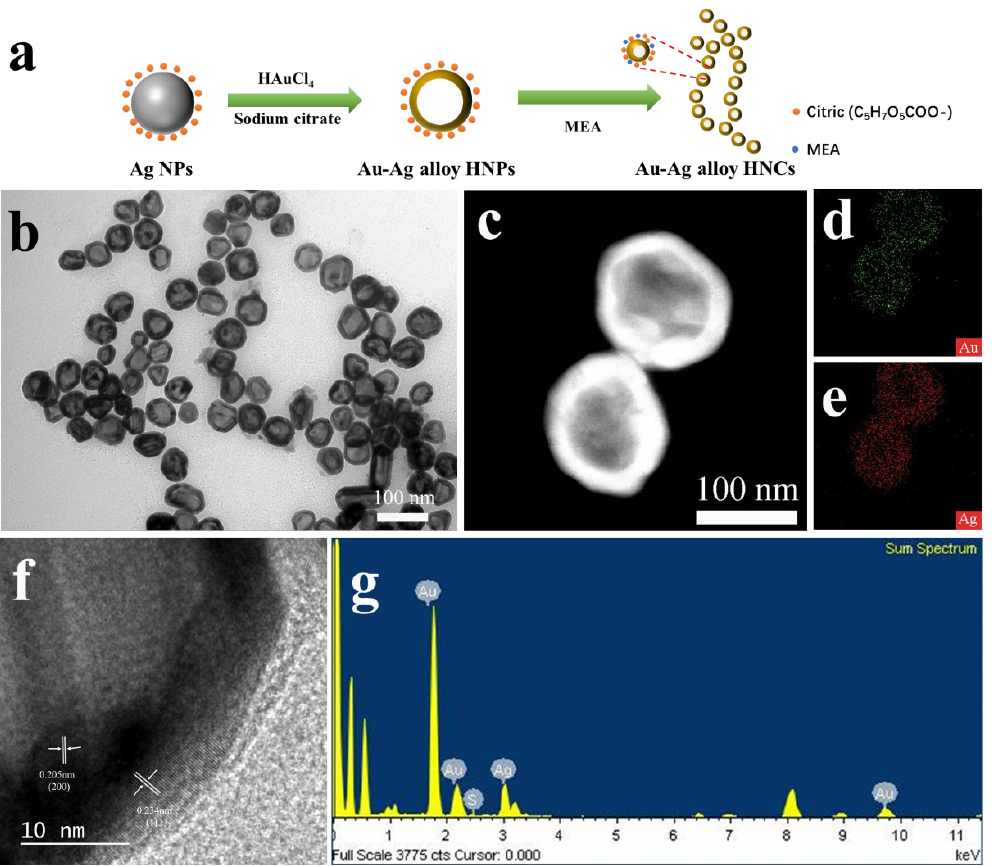
Figure 1. Synthesis of Au–Ag alloy HNCs by a template-free self-assembly method. ( a ) A scheme illustrating the synthesis route of Au–Ag alloy HNCs. ( b ) TEM image of Au–Ag alloy HNCs. ( c – e ) HAADF and EDS mapping images of Au–Ag alloy HNCs, respectively. ( f ) HRTEM image of Au–Ag alloy HNCs. ( g ) EDS elemental analysis of the Au − Ag alloy HNCs.